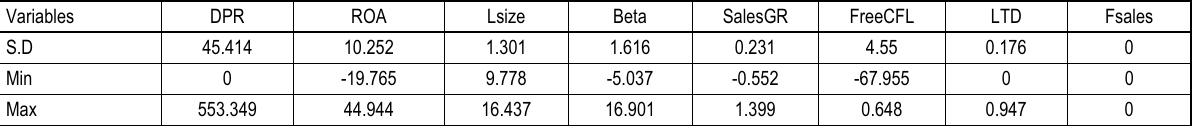
Table 2 (cont.). Descriptive statistics for all data